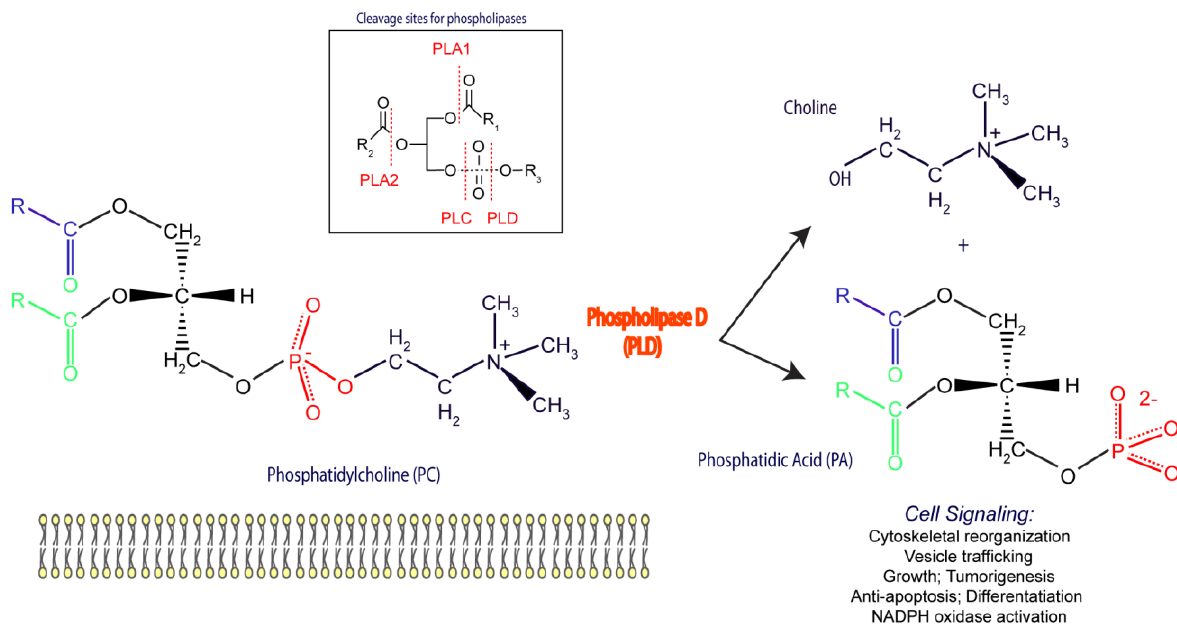
FIGURE 1. Substrate and products generated by the enzymatic action of PLD. The enzyme normally (albeit not exclusively) uses phosphatidylcholine that is hydrolyzed into choline and PA. The latter is a bona fide second messenger involved in many cellular functions (some included in the figure). The inset shows the sites of cleavage of PLD and related phospholipases in the glycerol backbone of the phospholipid